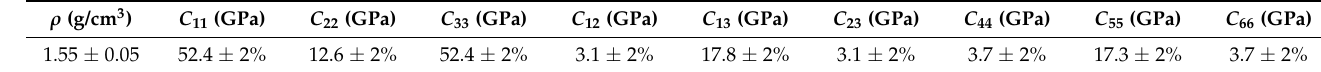
Table 1. Homogenized elastic properties of the carbon fiber reinforced composite plate.